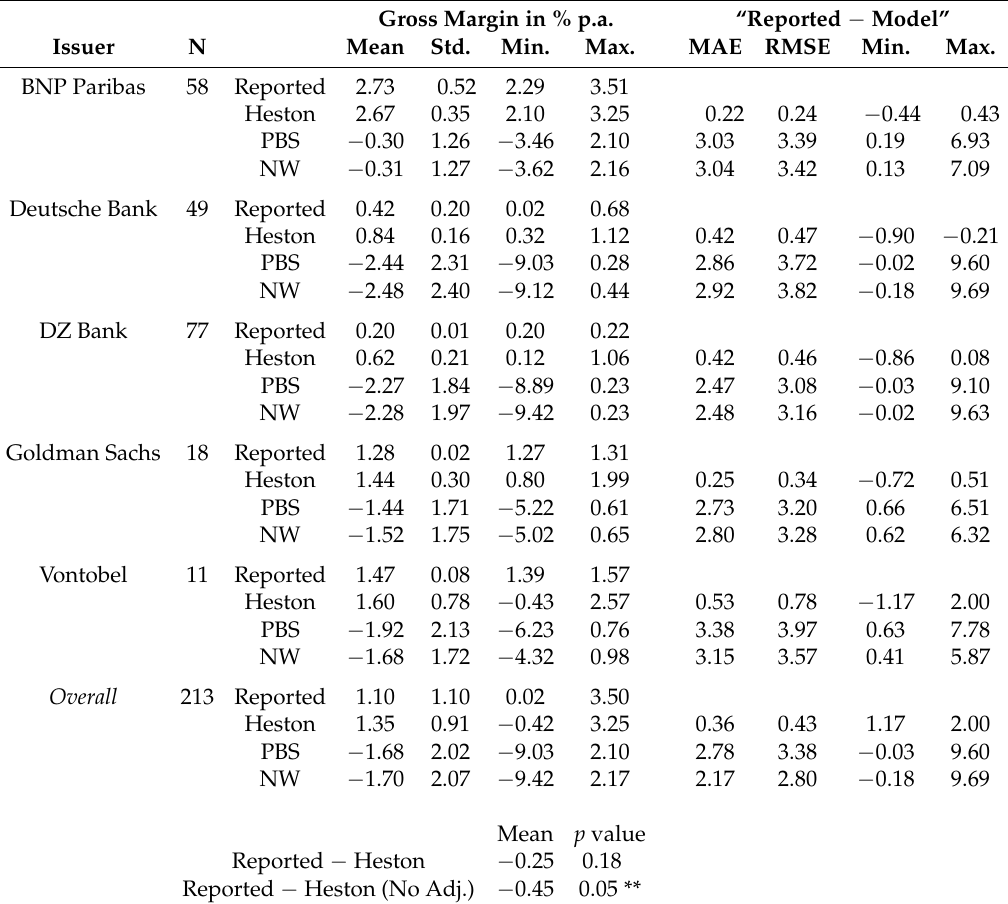
Table 3. Result Summary Statistics for Capped Bonus Certificates. Gross Margin in %